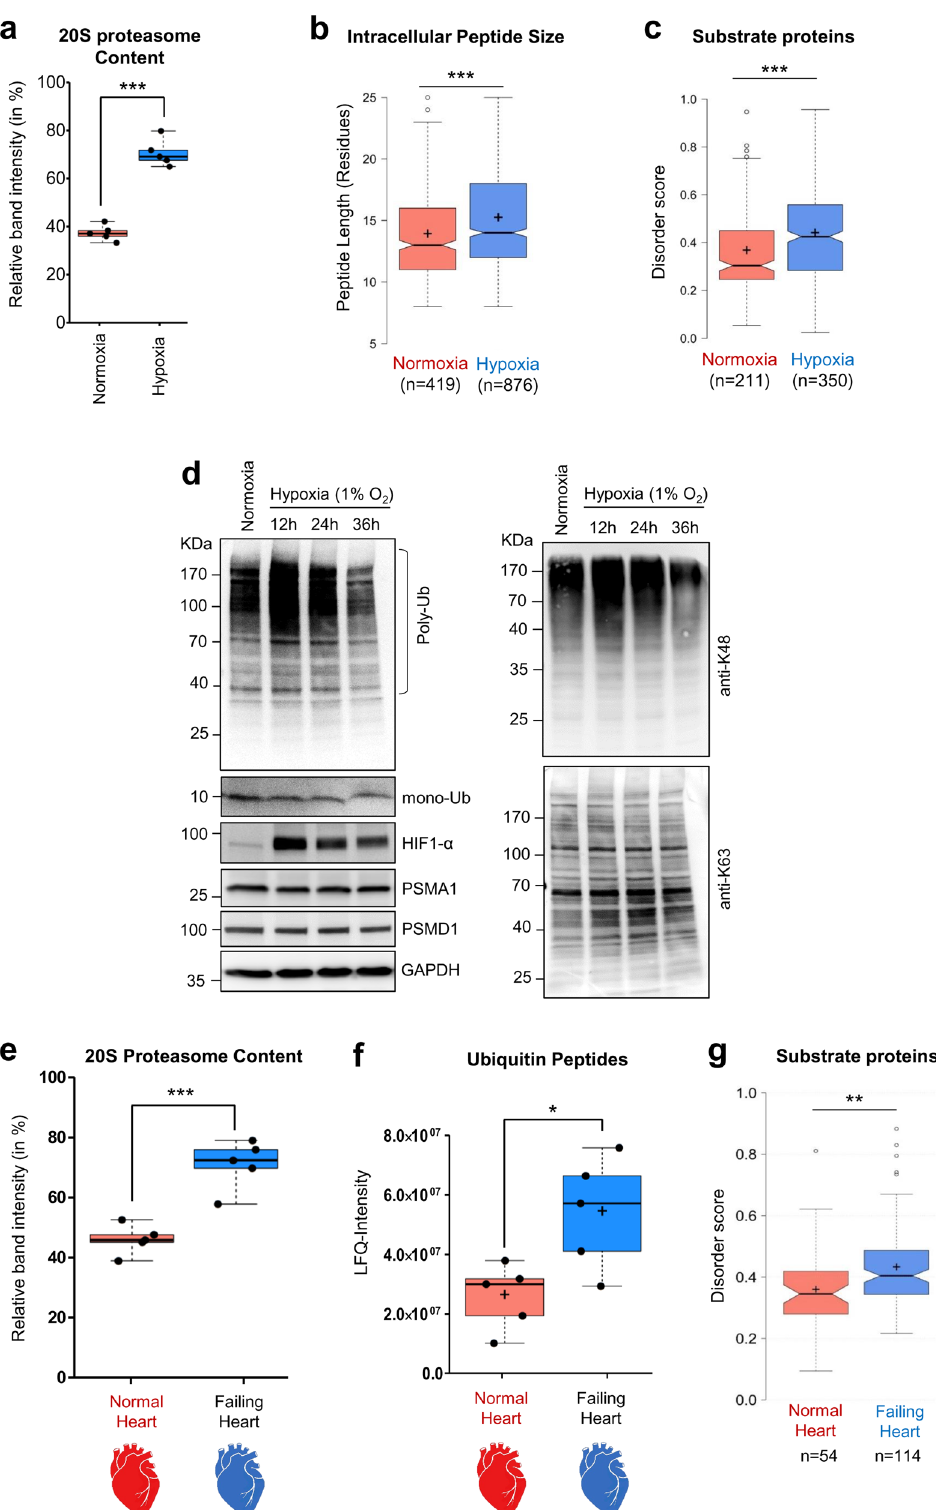
contacts provide local secondary structure melting. Indeed, we observed binding of a ubiquitinated substrate induced dis- continuous density and conformational dynamics in the center of the 20S α -ring of suf fi cient dimensions to potentially enable simultaneous entry of a few polypeptides. Unfolding may even occur in two steps: partial unfolding as ubiquitin traverses the outer pore in the α -ring and enters the antechamber, followed by